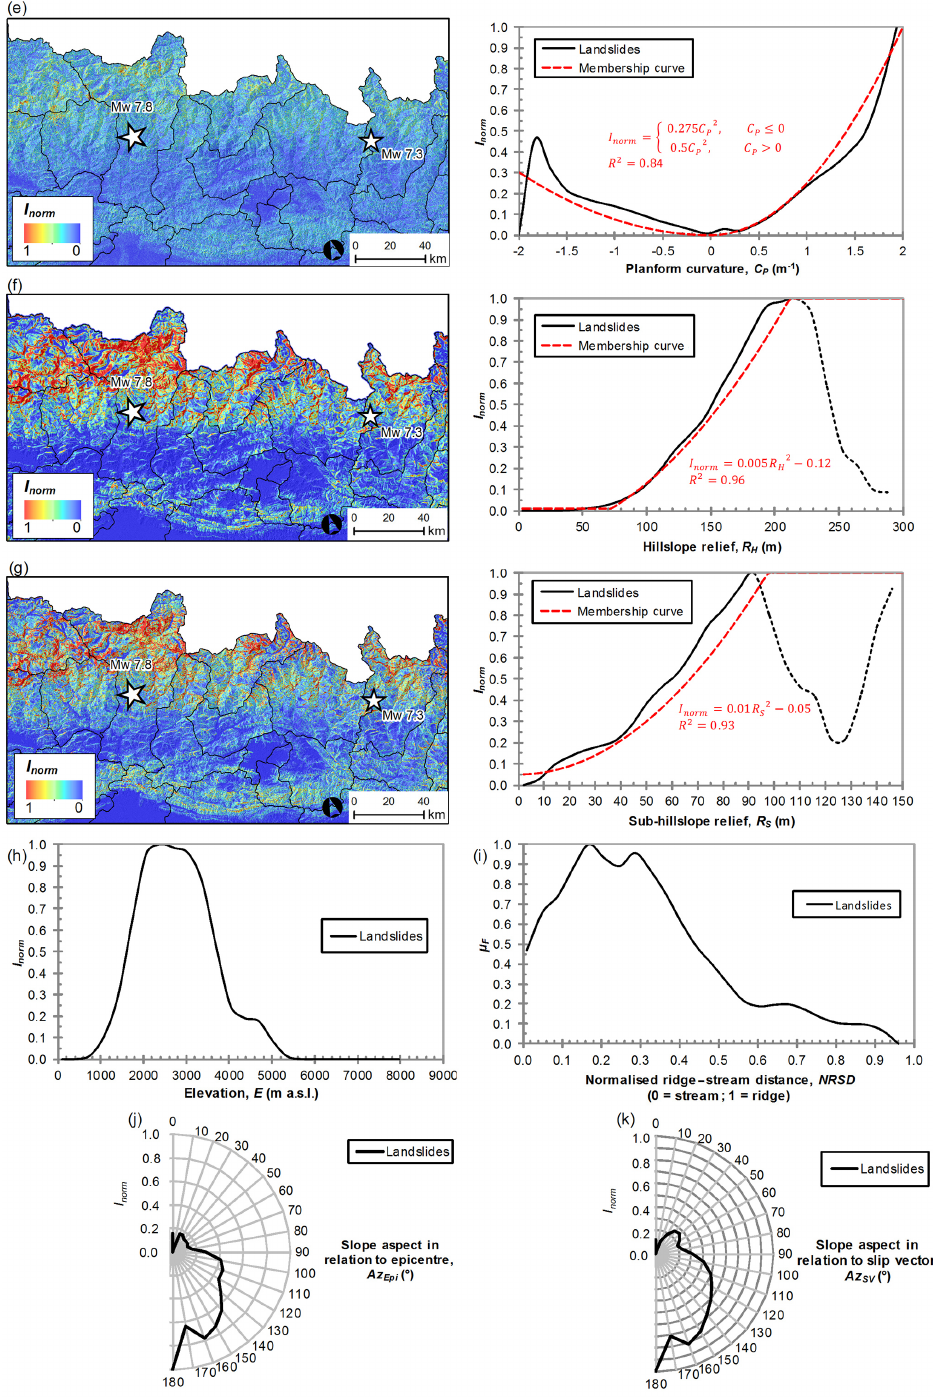
Figure 3. Predisposing factor influence on landslide occurrence. Panels (a–g) show influence maps, normalised kernel density estimates, and membership functions, f (I norm ) , for factors with relationships that match the broad physical expectation: (a) slope angle, (b) distance from fault plane, (c) distance from rivers, (d) distance from river confluences, (e) planform curvature, (f) hillslope relief, and (g) sub-hillslope relief. Short-dashed sections of normalised kernel density estimates are not used in establishing the R 2 values due to the small number of cells representing these values. Panels (h–k) show factors with relationships does not match physical expectations and cannot otherwise be explained: (h) elevation, (i) normalised ridge–stream distance (NRSD), (j) aspect relative to epicentre, and (k) aspect relative to slip